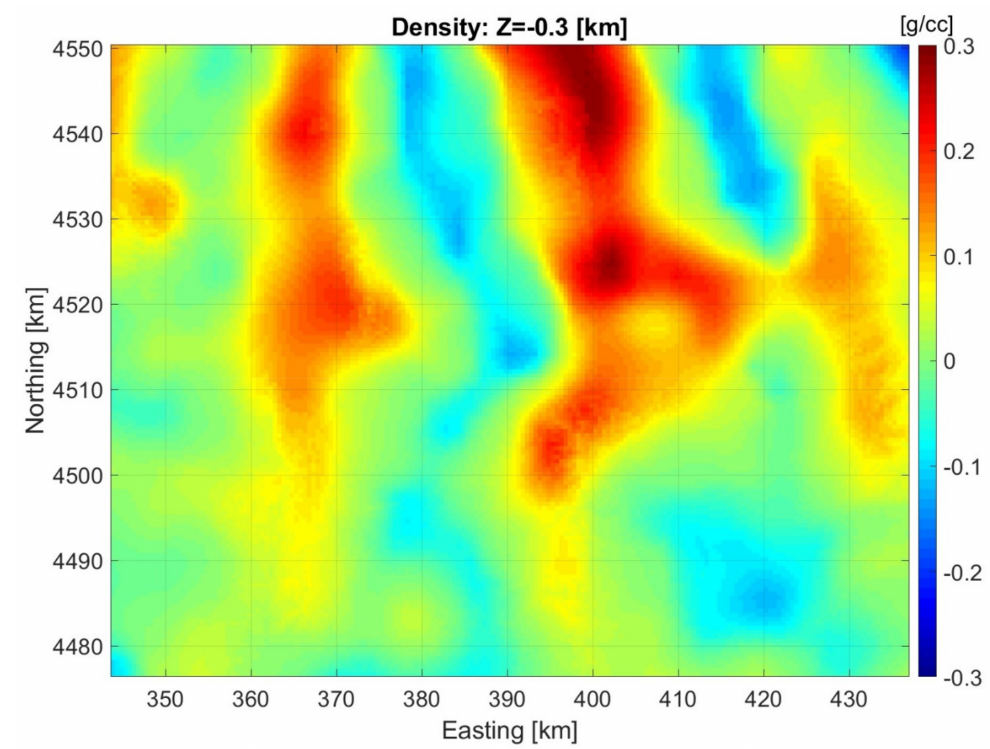
Figure 16. Horizontal section of the density inverse model produced by the inversion with a priori density contrast model at depth 0.3 km model below sea